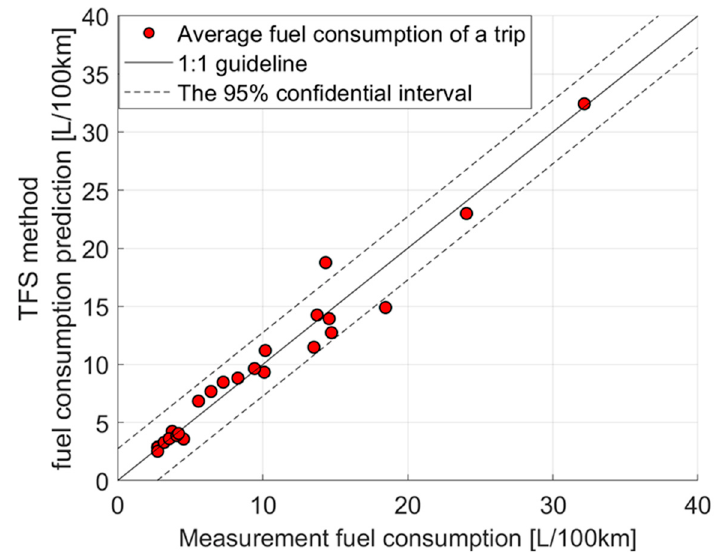
Figure 7. Fuel consumption prediction results of the third generation Toyota Prius (Prius3)’s traction force-speed based model.